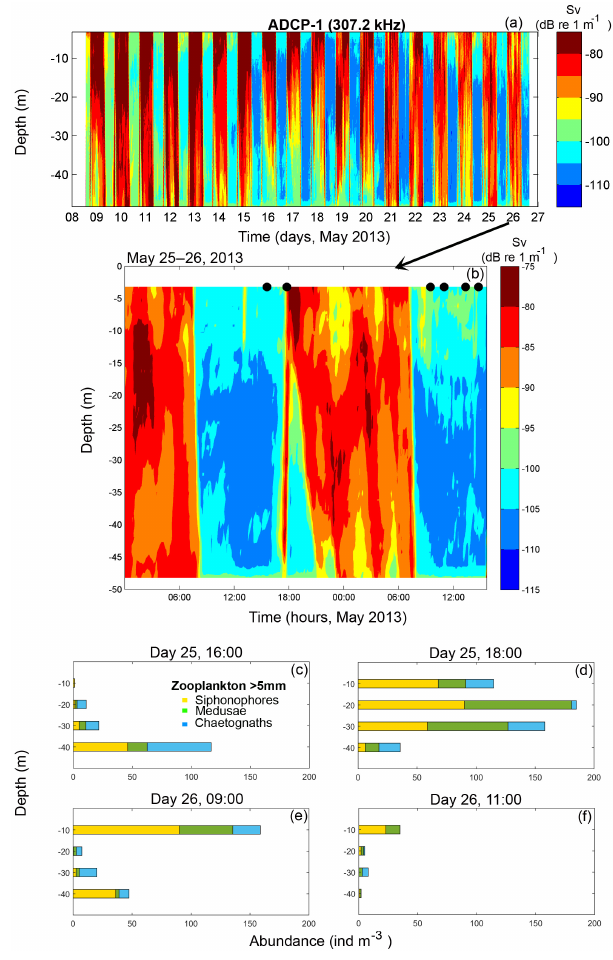
Figure 3. (a) Volume backscattering strength ( S v ) calculated from the ADCP-1 backscatter signal in Puyuhuapi Fjord, deployed at 50m depth from the 8 to 26 May 2013. (b) Zoom of the S v data and the times of in situ zooplankton sampling (black dots) carried out during 25–26 May 2013. (c, d) Vertical abundance of main zoo- plankton groups ( > 5mm length) from the in situ sampling at 16:00 and 18:00 (local time) on 25 May and (e, f) at 09:00 and 11:00 (local time) on 26